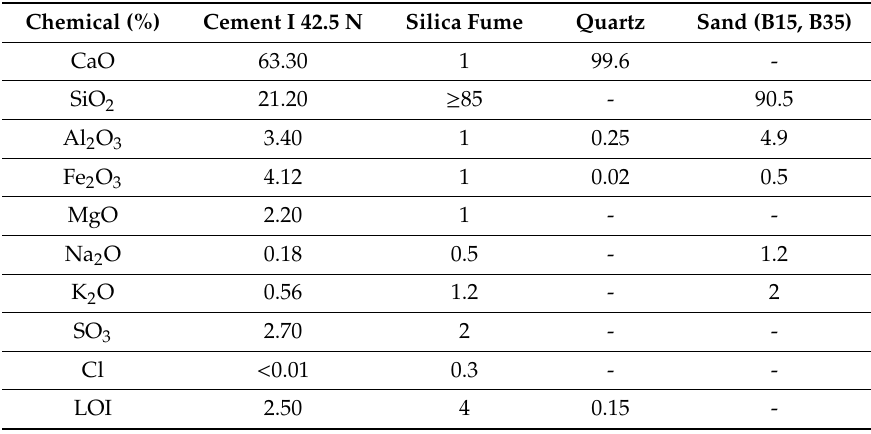
Table 2. Chemical composition of the used dry